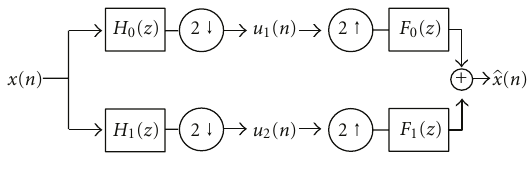
Figure 3: A two-channel QMF